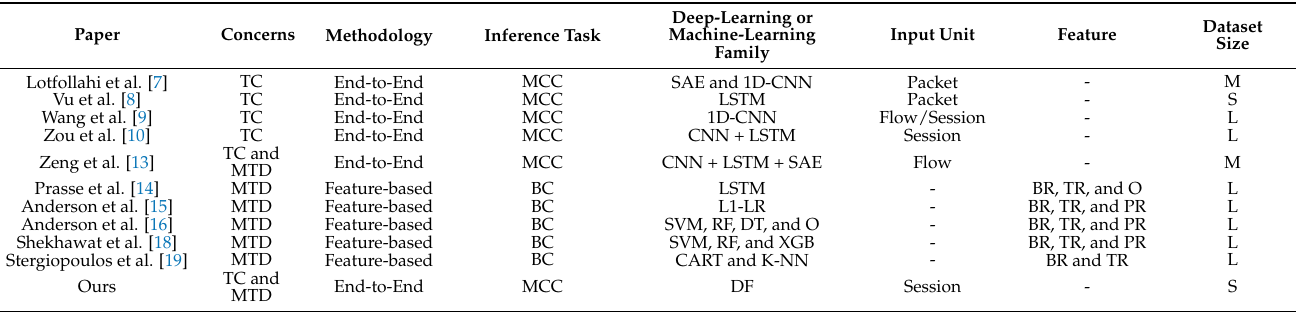
Table 2. Summary of related work.